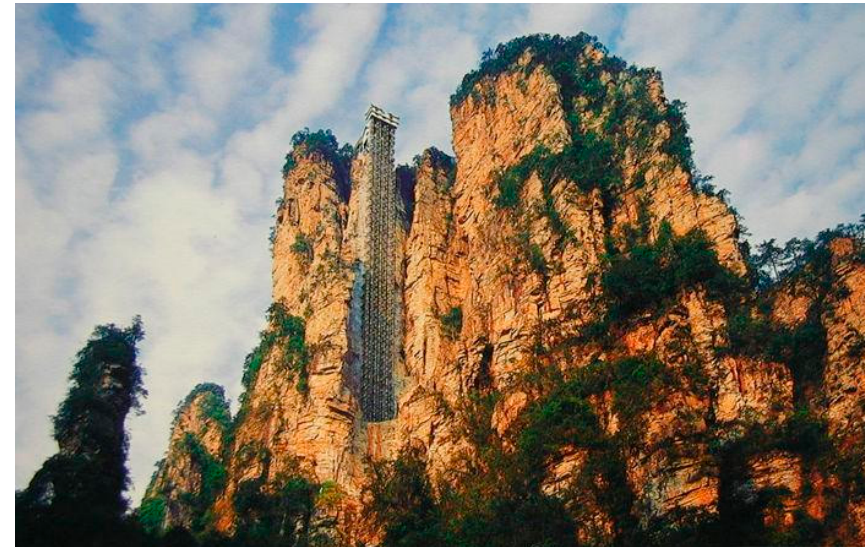
Figure 8. Sky Elevator in Zhangjiajie National Forest Park (source: http://www.cn-zhangjiajie.cn/index.html).